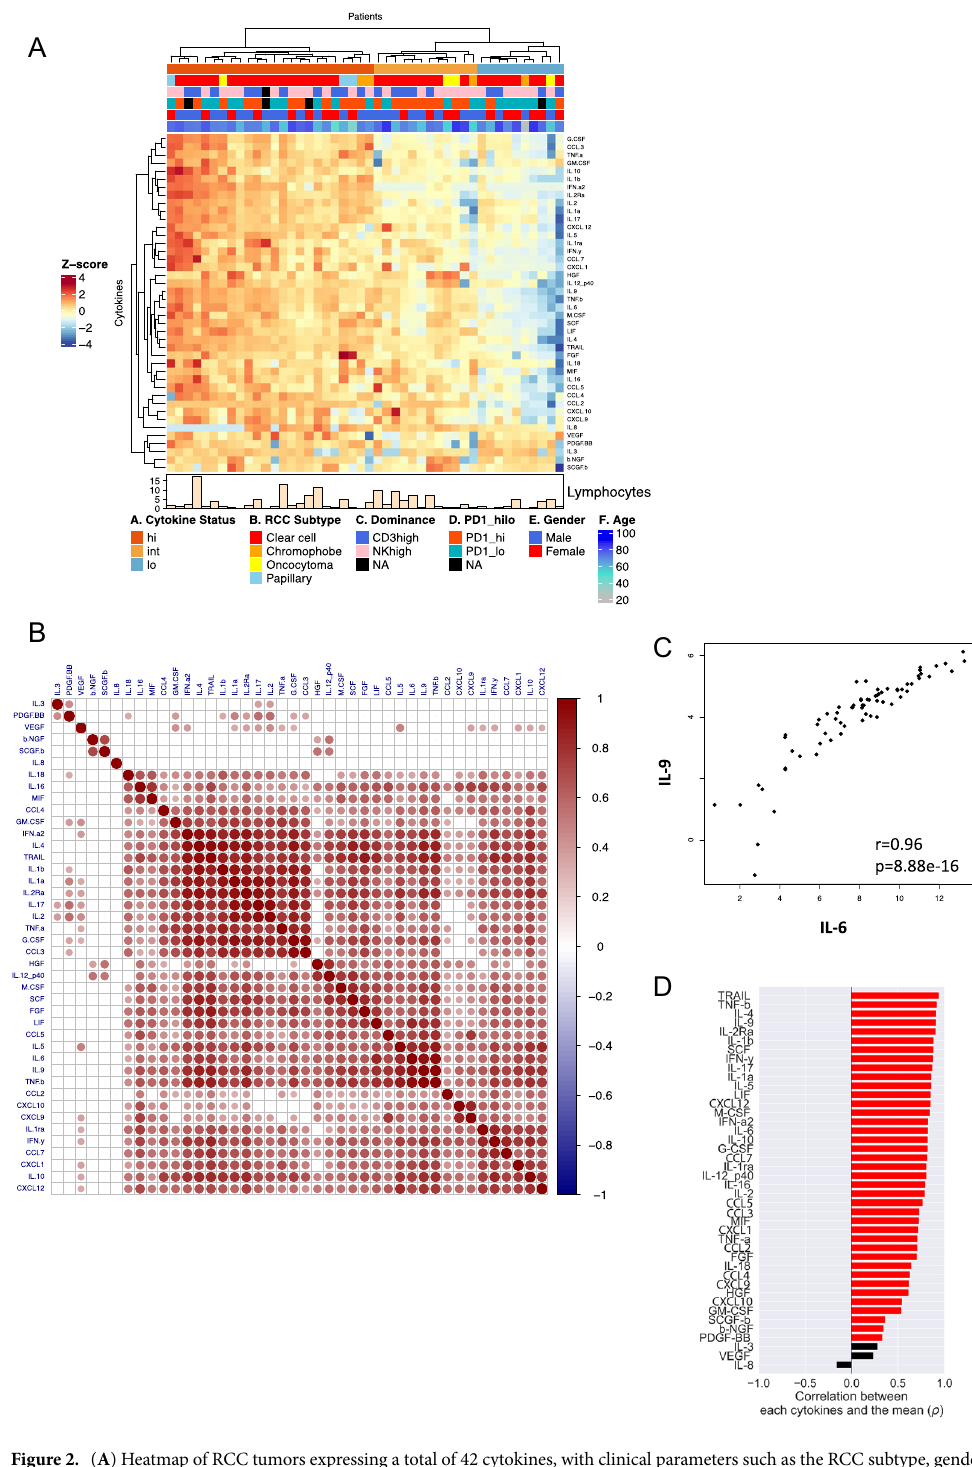
Figure 2. ( A ) Heatmap of RCC tumors expressing a total of 42 cytokines, with clinical parameters such as the RCC subtype, gender, and age. Unsupervised Euclidean distance clustering and ward.D2 linkage methods were used. RCC tumors have a distinct cytokine profile based on three clusters ((A) Cytokine Status): those with high (hi), intermediate (int), and low (lo) cytokine expressions. No marked differences were observed between the clinical parameters. The (C) Dominance and (D) PD1_hilo color keys refer to our previous studies 13 with RCC tumors that were subgrouped into CD3 + T and NK cell dominant tumors (Supplemental Fig. S3A), or CD4 + and CD8 + T cell PD-1 expression (Supplemental Fig. S3B). NAs refer to samples excluded from the analysis or with missing clinical data. ( B ) Correlation plot using Spearman rank correlation shows strong positive correlations across most of the cytokines expressed in the tumor. However, different expression patterns were observed for a few cytokines (IL-3, PDGF-BB, VEGF, β-NGF, and SCGF-β). IL-8 was the only cytokine that showed no correlation with any of the measured cytokine levels. Only statistically significant cytokines (Bonferroni-Hochberg corrected with a false discovery rate (FDR) < 0.05) are shown. ( C ) Spearman’s correlation plot showing IL-6 and IL-9 as one of the strongest positively correlating cytokines. ( D ) Pearson’s correlation analysis using the python- based tool, CytoMod 18 , shows correlations between each absolute cytokine expression and mean cytokine levels of each tumor sample, revealing significantly positive correlations, except for IL-8 that showed a negative